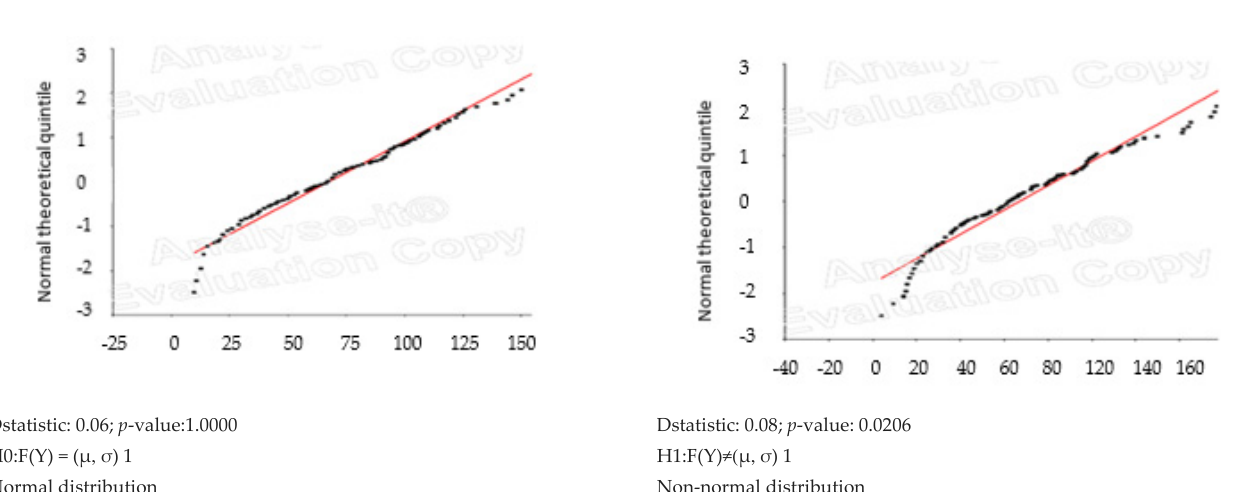
Figure 3. Statistical differences (Kolmogorov–Smirnov Test) between SO 2 results obtained by the official method and winescan technology. The continuous line represents the normal distribution. The dashed dots represent the observed distribution.